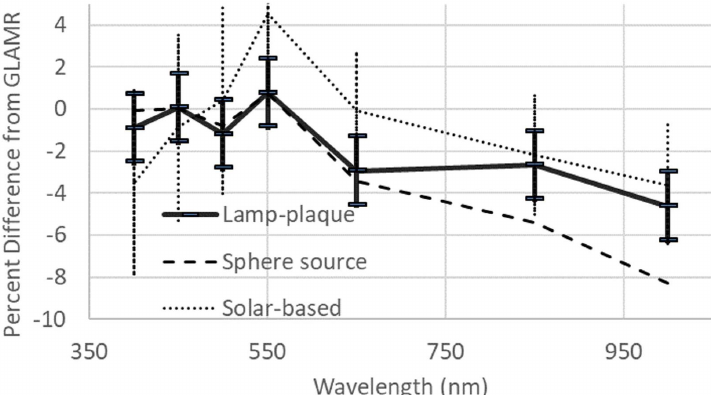
Figure 19. Percent difference between GLAMR-based absolute radiometric calibration of the mul- tispectral field transfer radiometer and the lamp–plaque source-based approach (solid line). Error bars indicate the combined k = 2 uncertainty of the source- and detector-based methods. Shown for reference also are sphere-based and source-based results with combined uncertainty error bars shown for the solar-based method (sphere-based are similar to those of